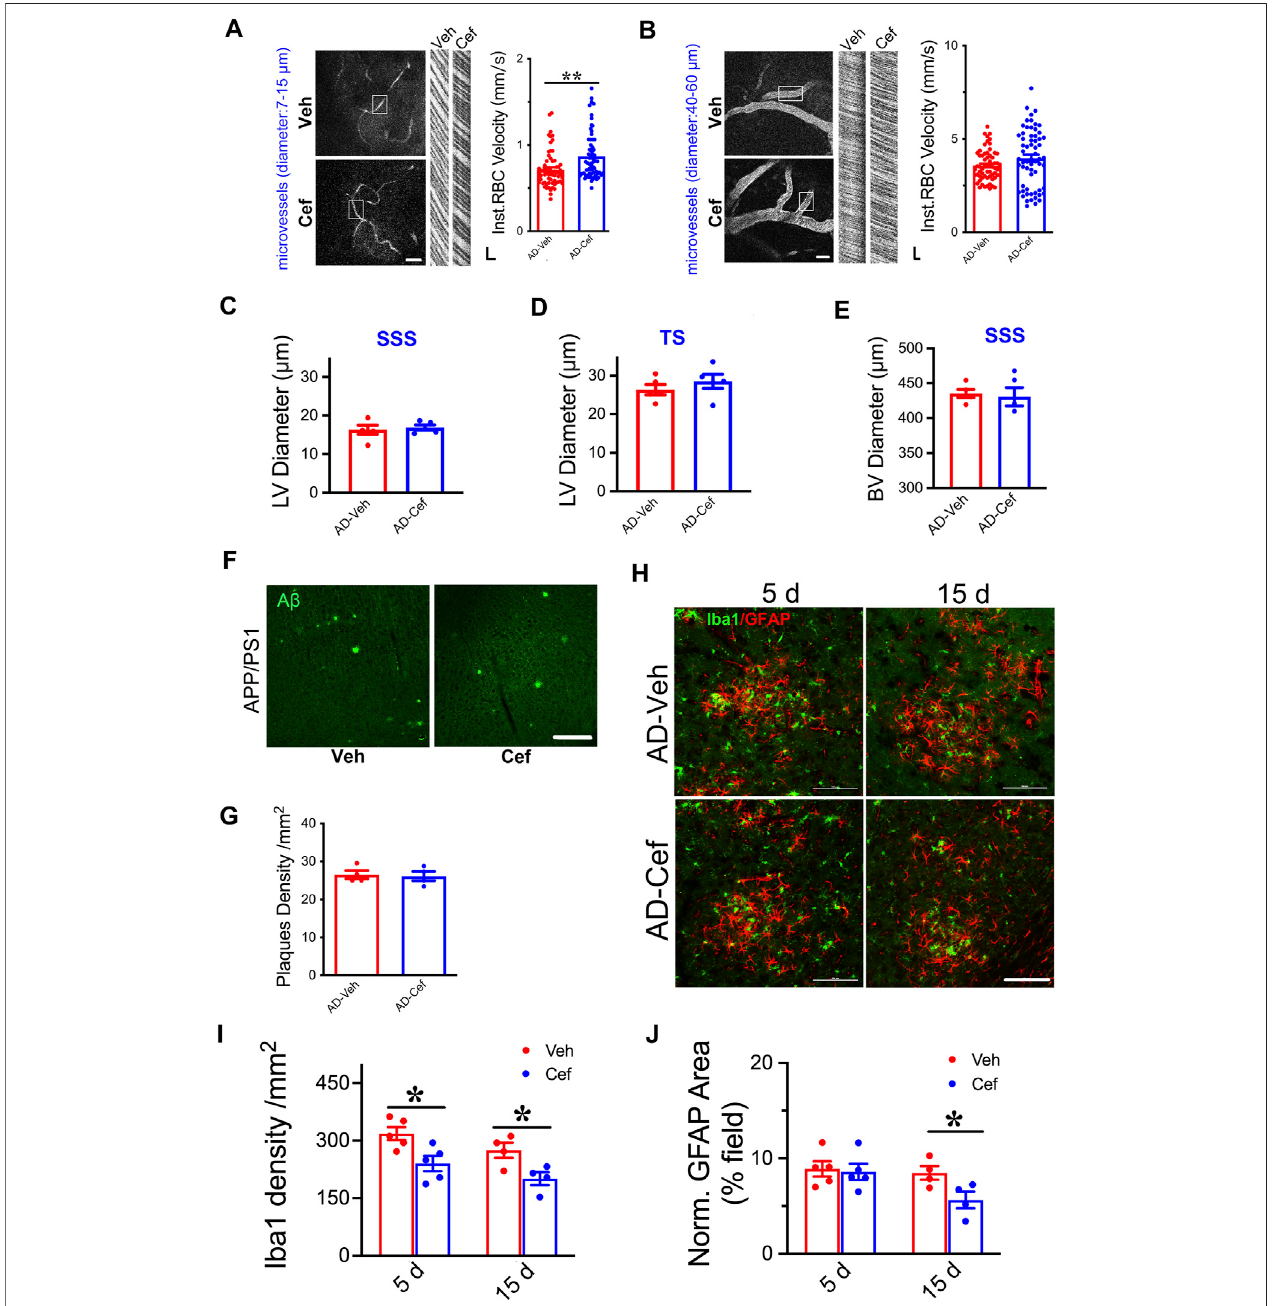
FIGURE6 | Impacts ofCef on CBF and lymphatic vesselstructure in APP/PS1 mice. (A) Sample image ofsmall BVs (diameter, 7 – 15 μ m, left ) and linescan image of blood fl ow (right) . Scale bar, 100 μ m (left) , 10 ms, and 10 μ m (right) ( p (cid:2) 0.0003, t -test, n (cid:2) 64 BVs/4 mice per group). (B) Sample image of large BVs (diameter, 40 – 60 μ m, left ) and line scan image of blood fl ow (right) . Scale bar, 100 μ m (left) , 10 ms, and 10 μ m (right) ( p (cid:2) 0.0747, t -test, n (cid:2) 64 BVs/4 mice per group). (C) Quanti fi cationofthediameteroflymphaticductsinmicetreatedwithCeforVehintheSSSregion( p (cid:2) 0.1316, t -test, n (cid:2) 5micepergroup). (D) Quanti fi cationofthe diameter of lymphatic ducts in mice treated with Cef or Veh in the TS region ( p (cid:2) 0.1241, t -test, n (cid:2) 5 mice per group). (E) Quanti fi cation of the diameter of BVs in mice treatedwithCeforVehintheSSSregion( p (cid:2) 0.3436, t -test, n (cid:2) 5micepergroup). (F) SampleimagesofA β staininginthecortexofAPP/PS1micetreatedwitheitherCef or Veh. Scale bar, 100 μ m. (G) Quanti fi cation of amyloid plaque density in APP/PS1 mice treated with Cef or Veh ( p (cid:2) 0.8199, t -test, n (cid:2) 4 mice per group). (H) Sample imagesofIba1orGFAPstainingincortex(S1)ofAPP/PS1micetreatedwitheitherCeforVeh,for5 days (left) or15 days (right) .Scalebar,100 μ m. (I) Quanti fi cationof Iba1densityinAPP/PS1miceaftertreatmentwithCefforeither5 days( p (cid:2) 0.0173, t -test, n (cid:2) 5micepergroup)or15 days( p (cid:2) 0.0301, t -test, n (cid:2) 4micepergroup). (J) Quanti fi cation of GFAP + area in APP/PS1 mice after treatment with Cef for either 5 days ( p (cid:2) 0.7982, t -test, n (cid:2) 5 mice per group) or 15 days ( p (cid:2) 0.0447, t -test, n (cid:2) 4 mice per group). Data are mean ± SEM. * p < 0.05; ** p < 0.01.